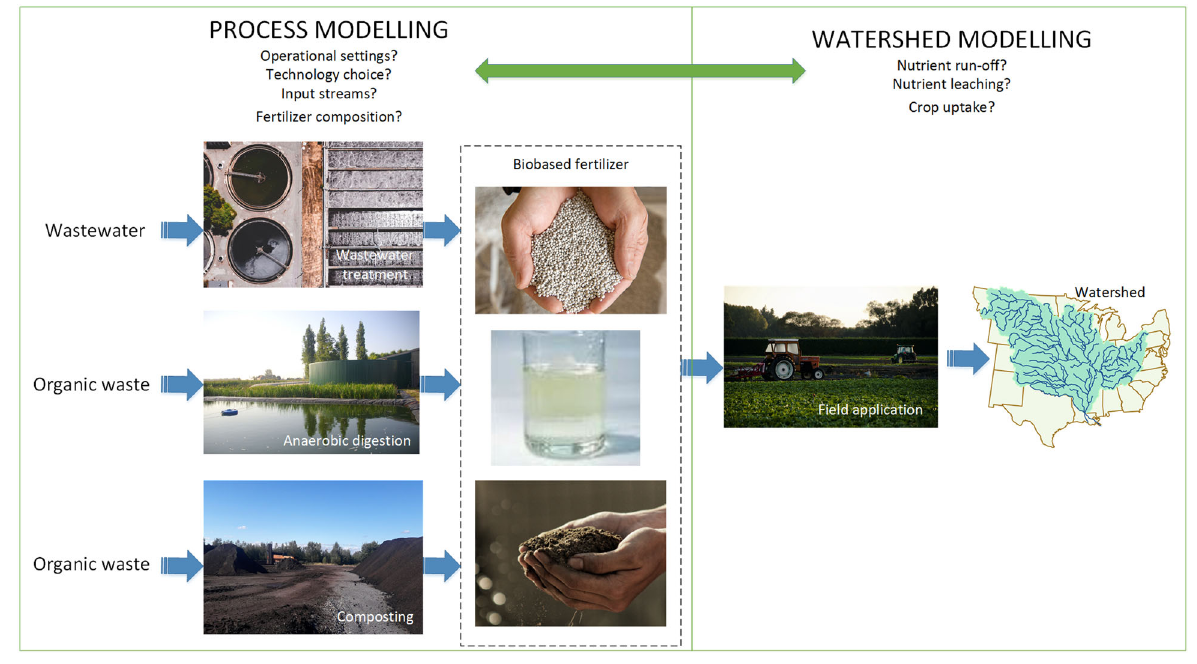
Fig. 1 Concept of integrated process and watershed modelling. Blue arrows represent nutrient fl ows. Interactions between process models and watershed models are marked. Image reuse permission: 1) wastewater treatment, Unsplash, Ivan Bandura, https://unsplash.com/; 2) anaerobic digestion, personal picture, Céline Vaneeckhaute; 3) composting, personal picture, Tania Santiago; 4) struvite fertilizer, Microsoft Bing Creative Commons, Ostara Nutrient Recovery, www.ostara.com, 5) liquid fertilizer, personal picture, Céline Vaneeckhaute; 6) compost, Unsplash, Gabriel Jimenez, https://unsplash.com/; 7) fi eld application, Unsplash, Naseem Buras, https://unsplash.com/; 8) watershed, Wikimedia Commons, Unknown Author Public Domain, File:Mississippi River Watershed.gif - Wikimedia